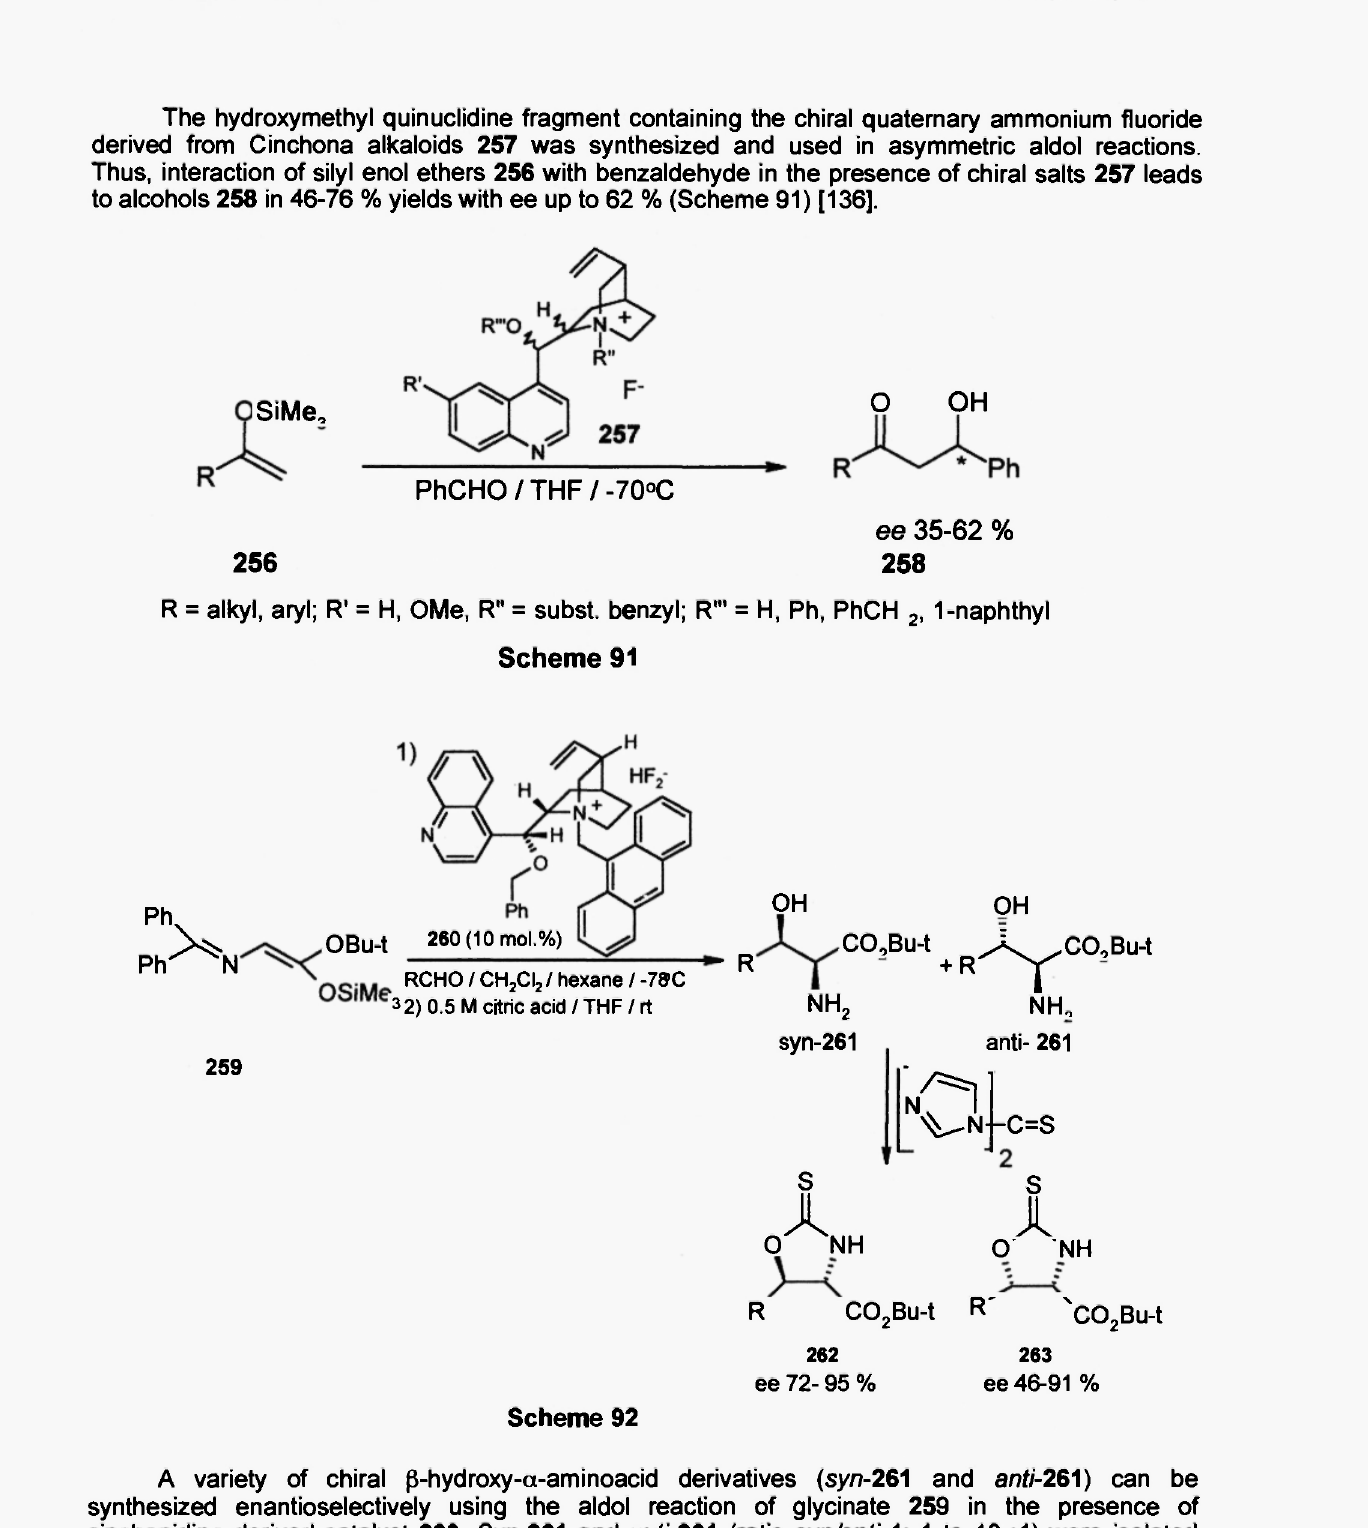
synthesized enantioselectively using the aldol reaction of glycinate 259 in the presence of cinchonidine derived catalyst 260. Syn -261 and anti- 261 (ratio syn/anti 1: 1 to 13 :1) were isolated in 48-81 % yields. Aminoacid esters syn -261 and anti- 261 were transformed to corresponding oxazolidine-2-thione derivatives 262 and 263 (ee up to 95%) by reaction with thiocarbonyl bisimidazole (Scheme